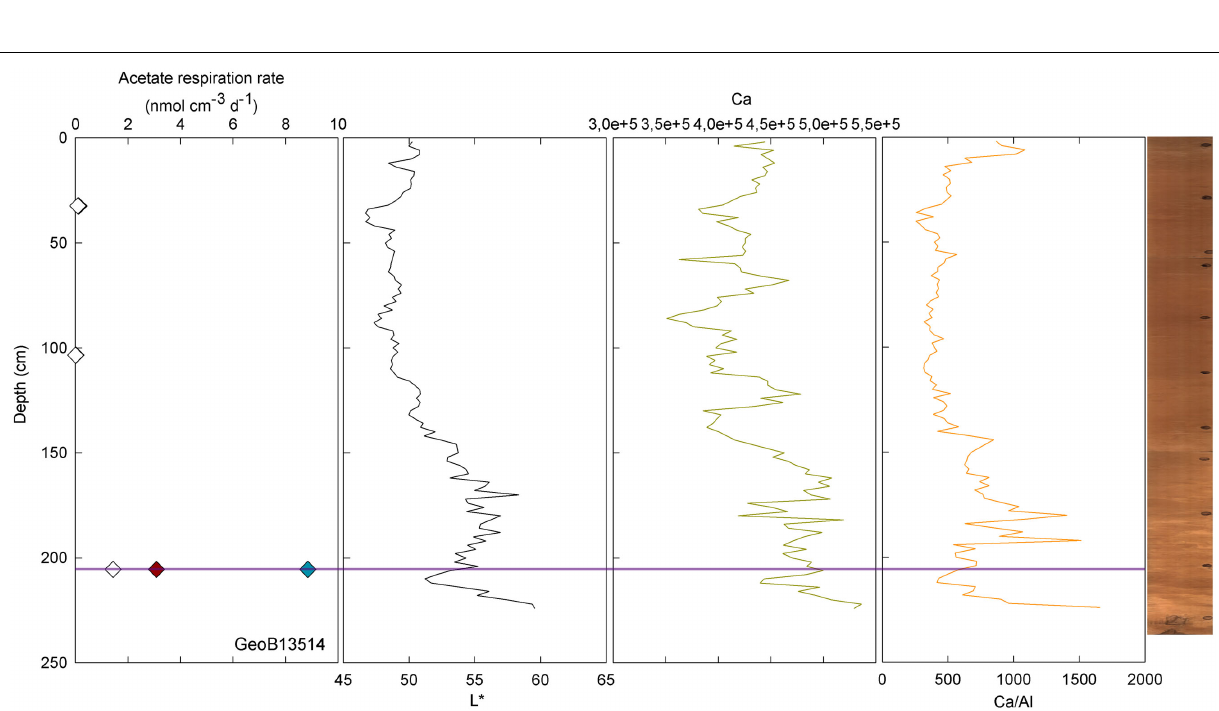
Frontiers in Microbiology | Extreme